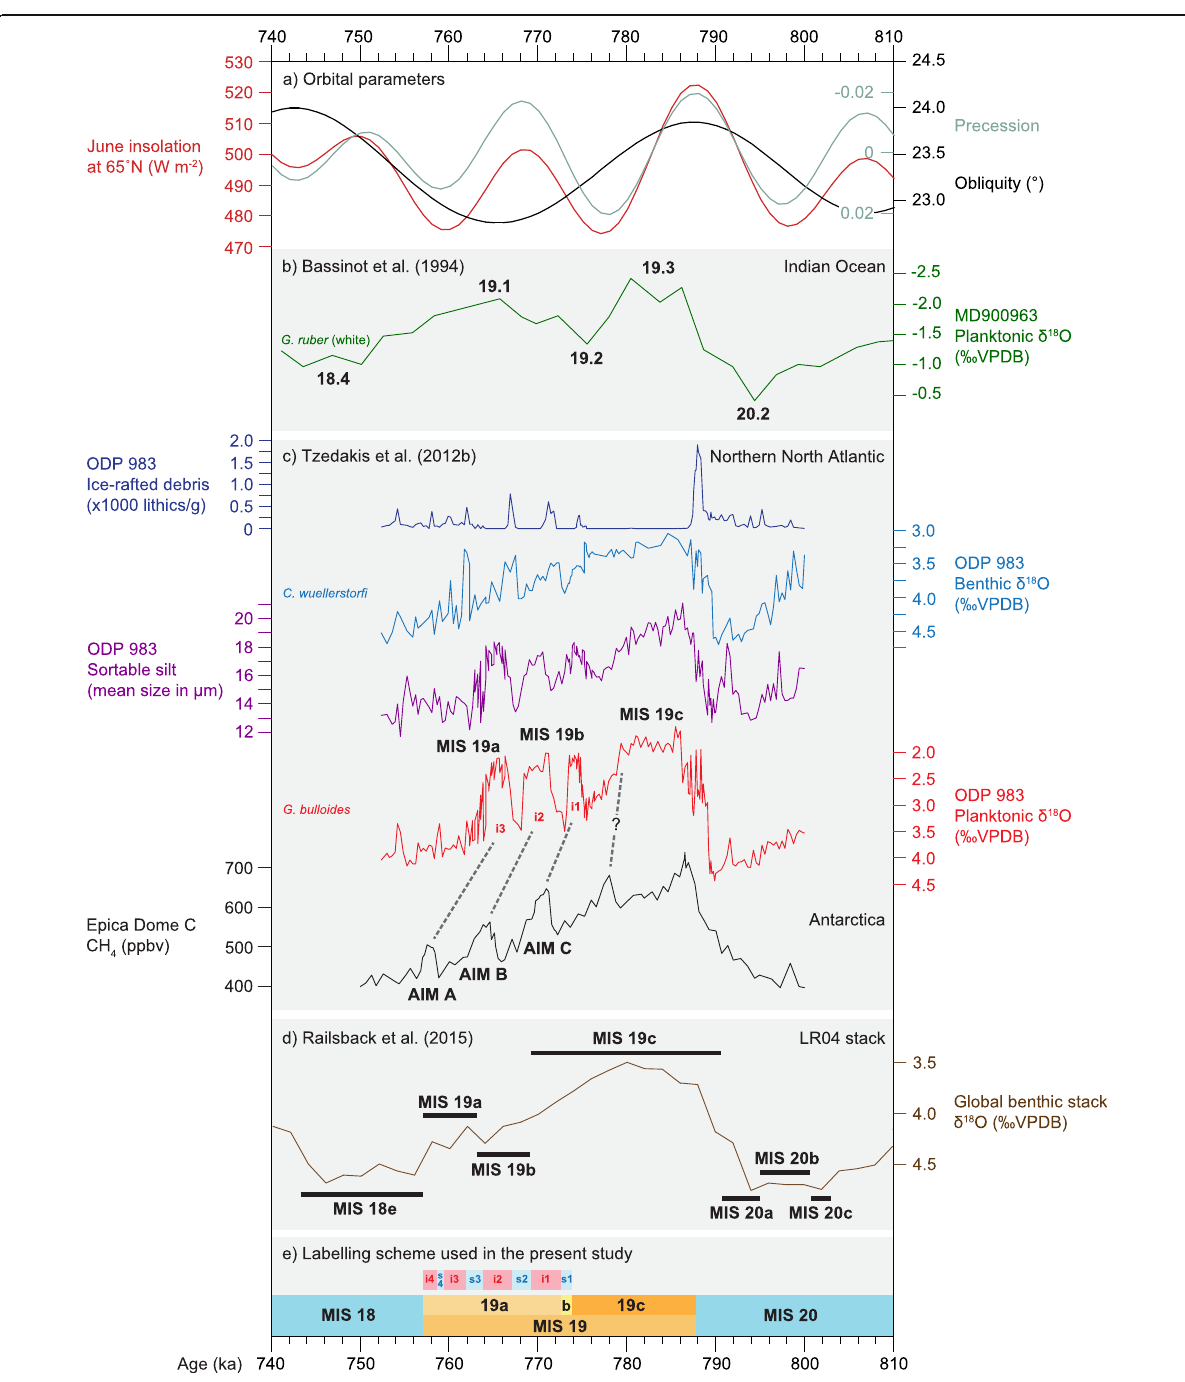
Fig. 8 North Atlantic and global records of Marine Isotope Stage 19 (see also Fig. 9). ( a ) Insolation at 65° N in June, and precession and obliquity parameters. ( b ) Designation of events by Bassinot et al. (1994) based on the planktonic foraminiferal δ 18 O record of Indian Ocean core MD900963. ( c ) Lettered substages of Tzedakis et al. (2012b) applied to the foraminiferal δ 18 O and other records of ODP Site 983 Iceland Basin, with peaks correlated to Antarctic Isotope Maxima (AIMs) reflected in the Antarctic ice-core methane record from EPICA Dome C. Also included are the ice-rafted debris and sortable silt mean size (mean of 10 – 63 μ m fraction) records (Kleiven et al. 2011). ( d ) Lettered substages of Railsback et al. (2015) as applied to the LR04 benthic δ 18 O foraminiferal stack of Lisiecki and Raymo (2005). ( e ) The MIS 19 subdivisional scheme used here (Fig. 7): interstadials i1, i2, and i3 are labelled in red. All records are plotted on their own published time scales and use the original substage